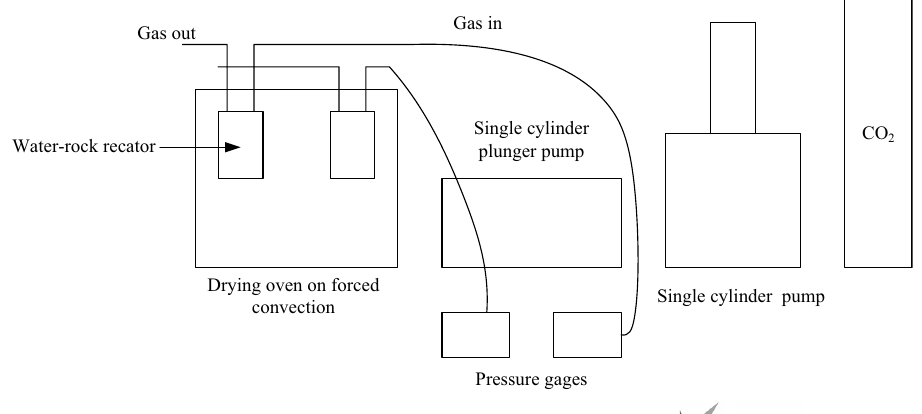
Fig. 3 The experimental